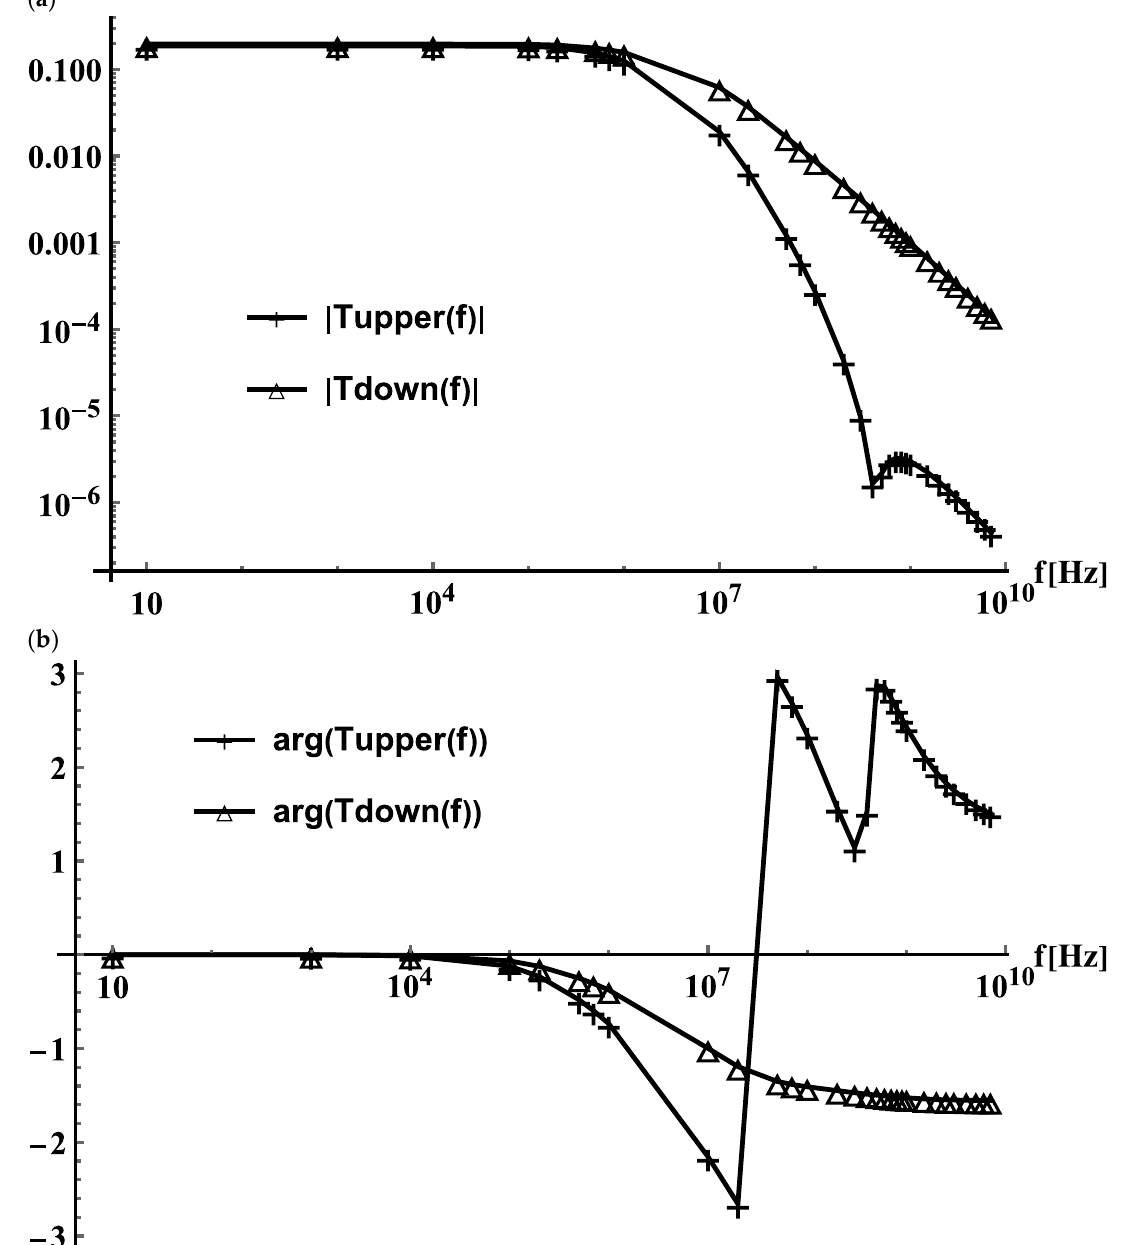
Figure 3. ( a ) The average value of |T(x,y,f)| in the upper and bottom resistor. ( b ) The average value of arg T(x,y,f) in the upper and bottom resistor.